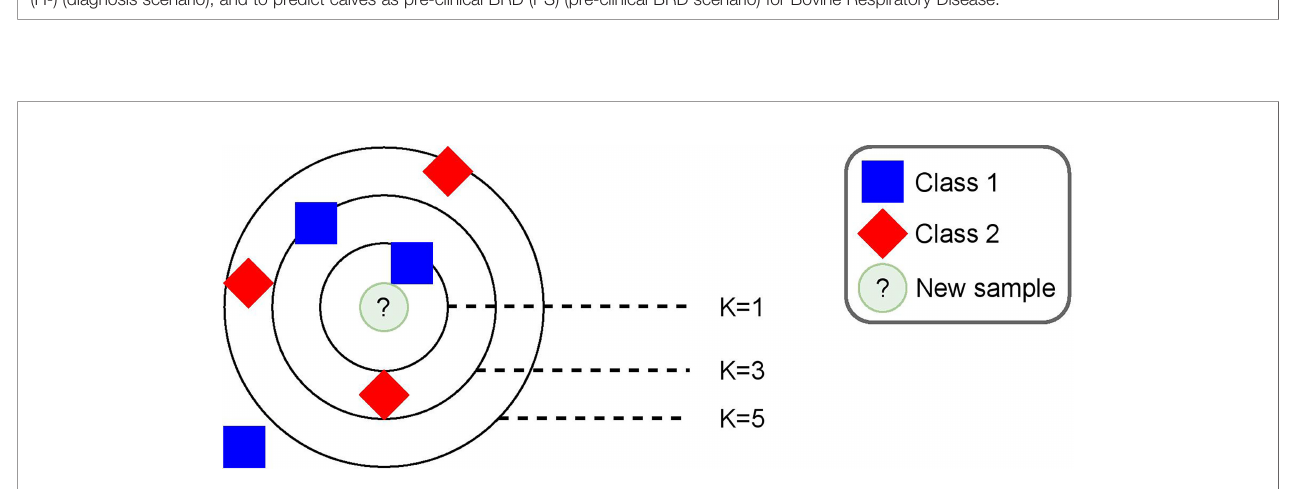
FIGURE 2 | Overview of training and testing splitting scheme for a K-Nearest Neighbor algorithm to classify 106 calves as sick (S+) or without respiratory disease (H-) (diagnosis scenario), and to predict calves as pre-clinical BRD (PS) (pre-clinical BRD scenario) for Bovine Respiratory